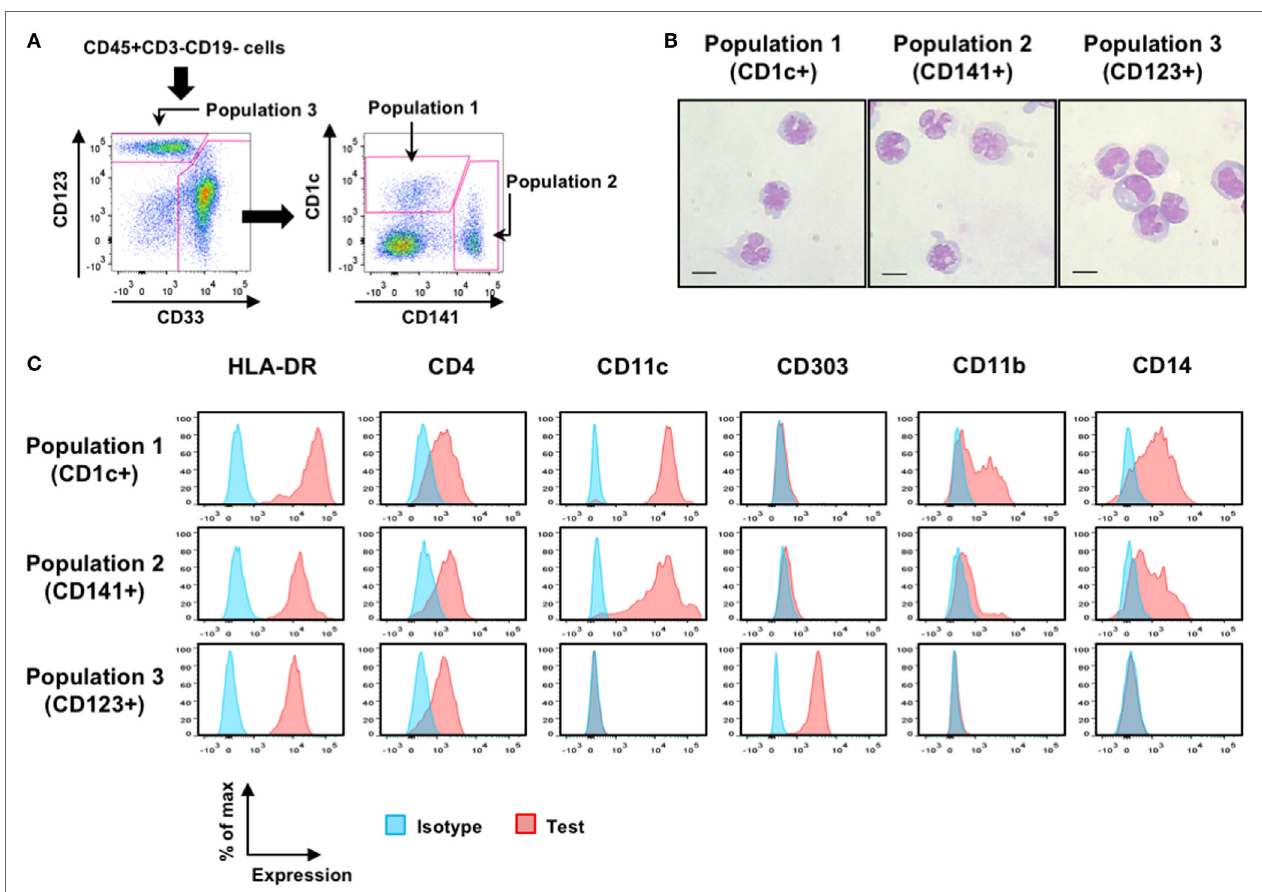
FigUre 2 | Characterization of putative human dendritic cell (DC) populations in hNOJ mice. (a) A representative gating strategy for flow cytometry of CD1c + population (Population 1), CD141 + population (Population 2), and CD123 + population (Population 3) using bone marrow (BM) cells from Group E. (b) May–Grünwald and Giemsa staining of each sorted putative DC population using pooled BM from four naïve hNOJ mice. Scale bars are 10 µm. (c) Representative histograms for subset-associated markers on splenic populations from Group